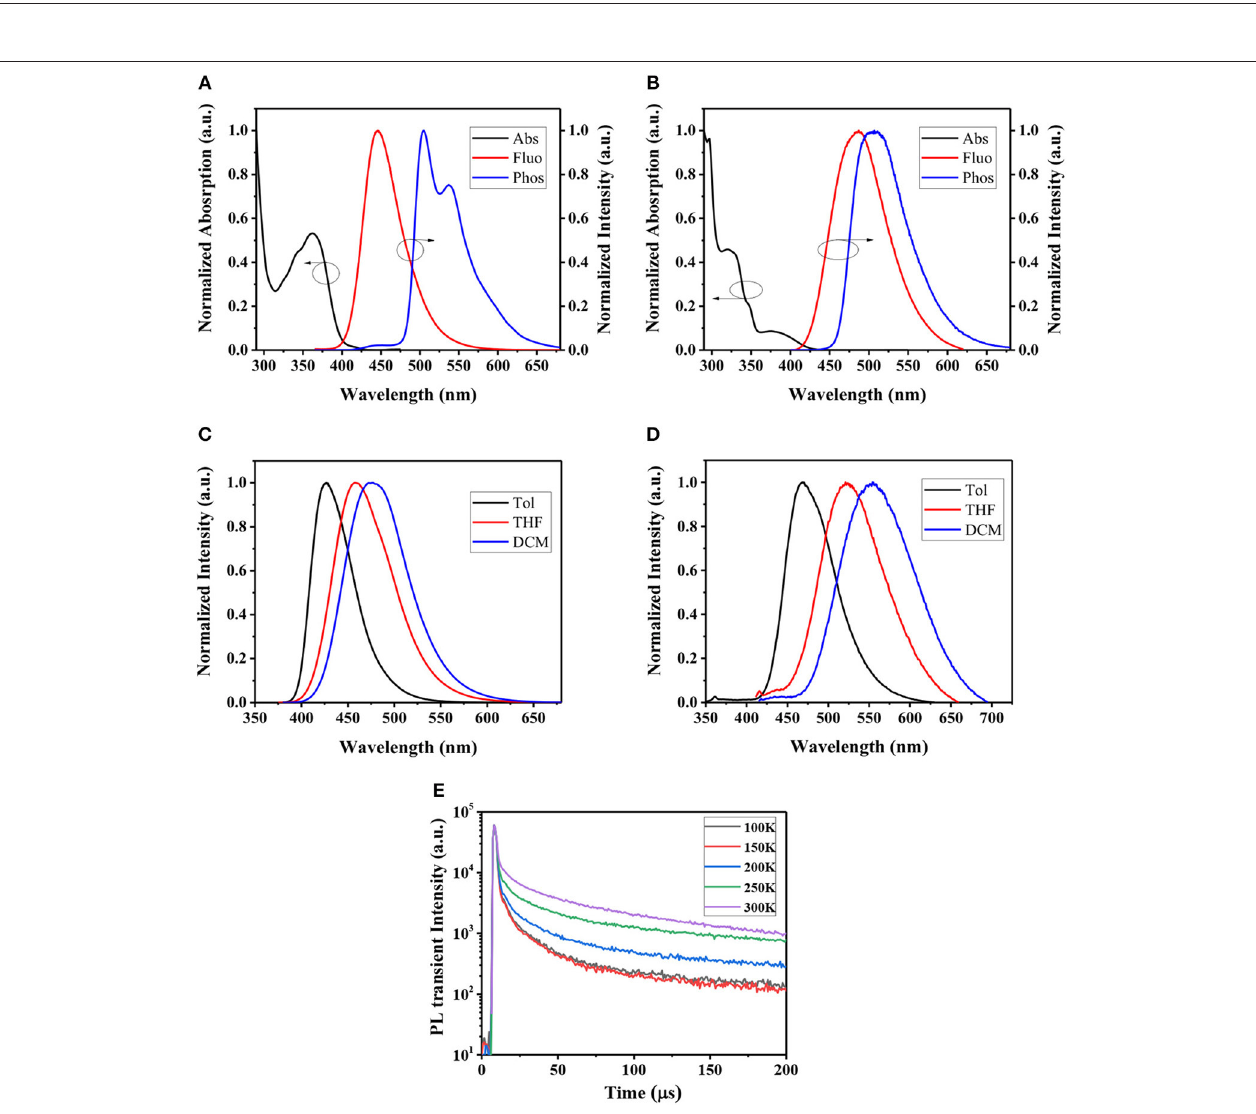
Frontiers in Chemistry |